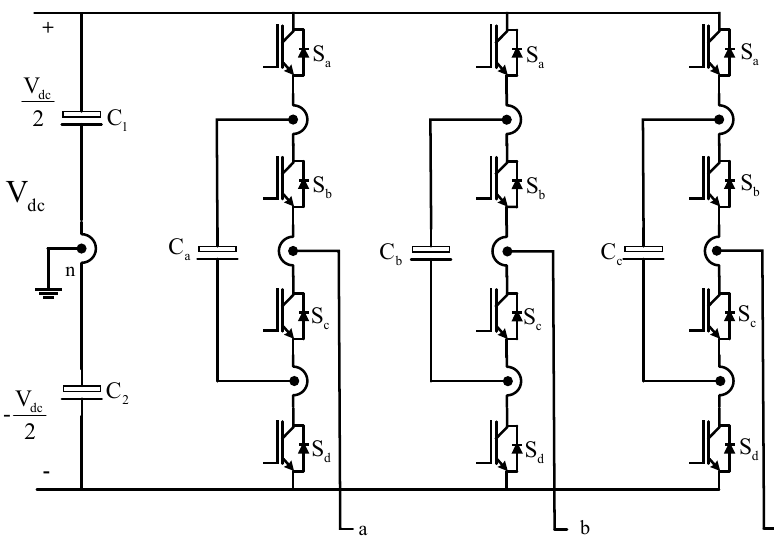
Figure 5. Three-level capacitor clamped/flying capacitor inverter.